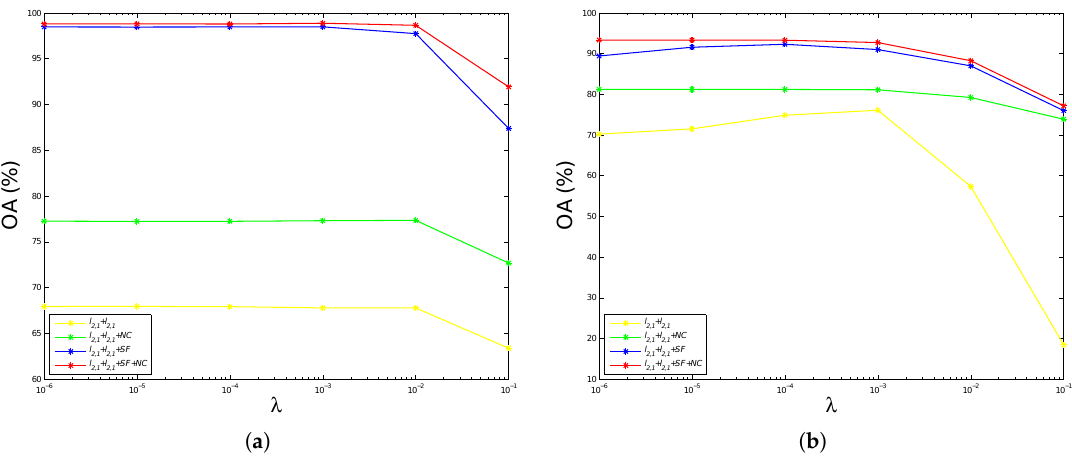
Figure 3. Performance of overall accuracy as a function of the parameter λ using the hyperspectral image of ( a ) Indian Pines; ( b ) Pavia